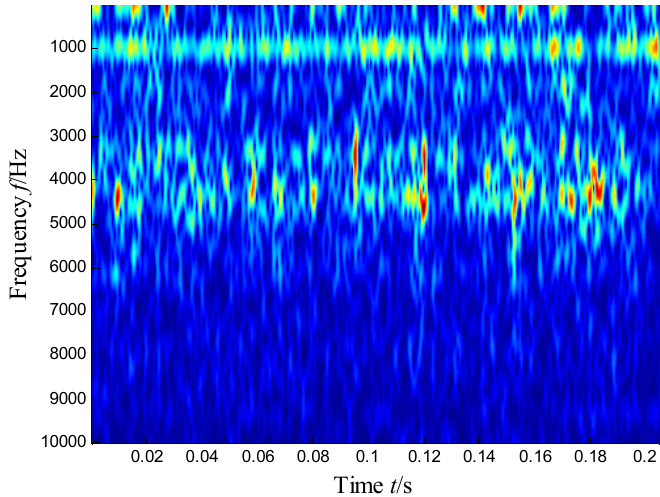
axis is associated with a serial number of the subspace. It is shown that SKNMF with sparsity constraint tends to provide a sparse weight distribution in Figure 5, where the corresponding subspace has a more concentrate frequency band. From the frequency distribution of Figure 5, the corresponding weights of the fifth and sixth subspaces in the main frequencies were concentrated and larger. Therefore, the union of the two subspaces was selected, and the corresponding time–frequency subspace shown in Figure 6 was calculated by Equation (16). The extracted signal was obtained by inverse STFT, as shown Figure 4. Time–frequency distribution of the outer race defect. in Figure 7a, and it revealed impulses compared with the original signal demonstrated in Figure 3. The spectrum of Figure 7b shows that the frequency band between 3100 Hz and 4400 Hz can be extracted adaptively, while the noise and other component interference can be eliminated effectively. The envelope analysis was performed on the extracted signal, and the corresponding envelope spectrum is shown in Figure 8. It is clear that the outer race fault characteristic f BPFO (236.4 Hz) denoted by a red arrow is rather evident. Besides, the second order harmonic of f BPFO denoted by another red arrow was also distinctive.